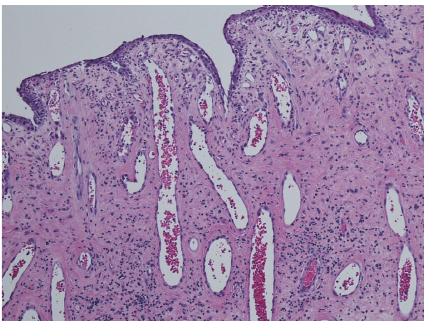
Figure 3: Histologic images highlighting the vascular and stromal componentscharacteristicofanasopharyngealangiofibroma.Image showing increased peripheral